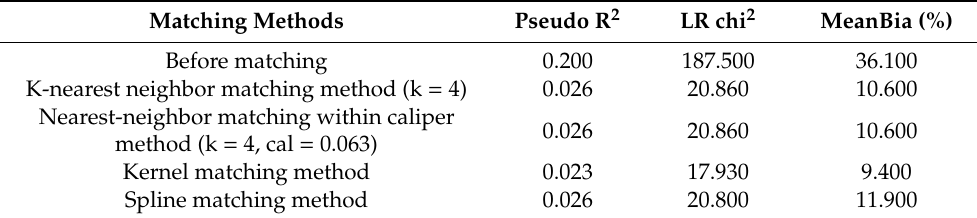
Figure 3. Density function graph after propensity score matching. Table 3. Balance test results before and after